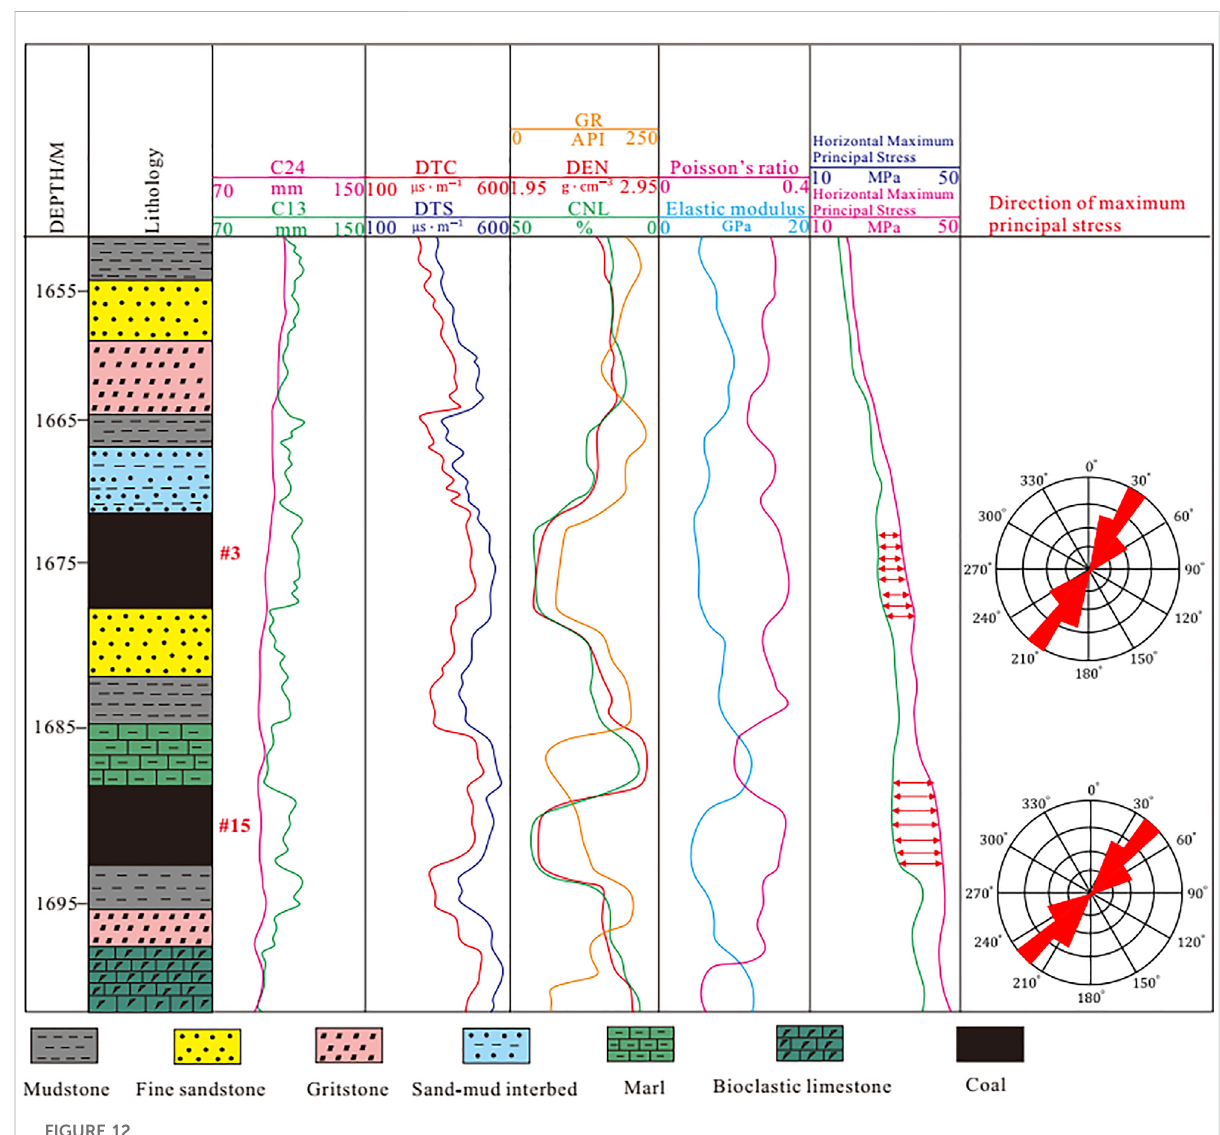
FIGURE 12 In situ stress prediction pro fi le of well S16.